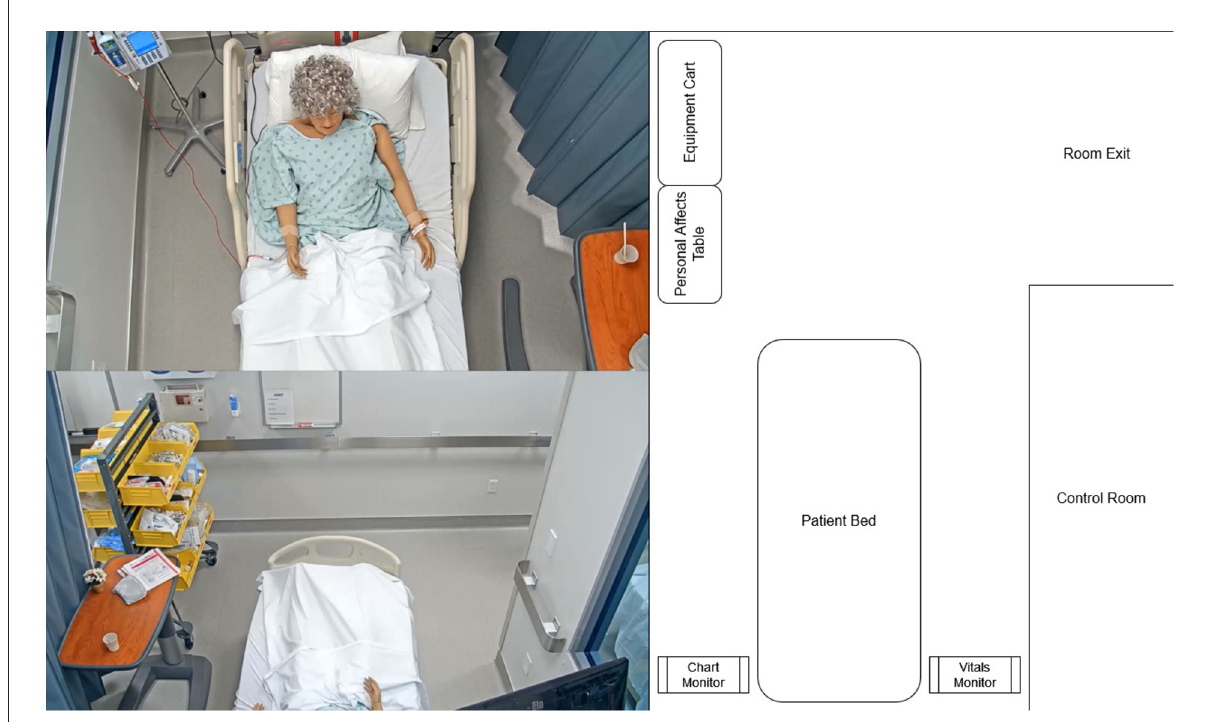
FIGURE3 Layout of the simulated hospital room from three viewpoints: the head camera (top-left), foot camera (bottom-left), and an abstract map representation